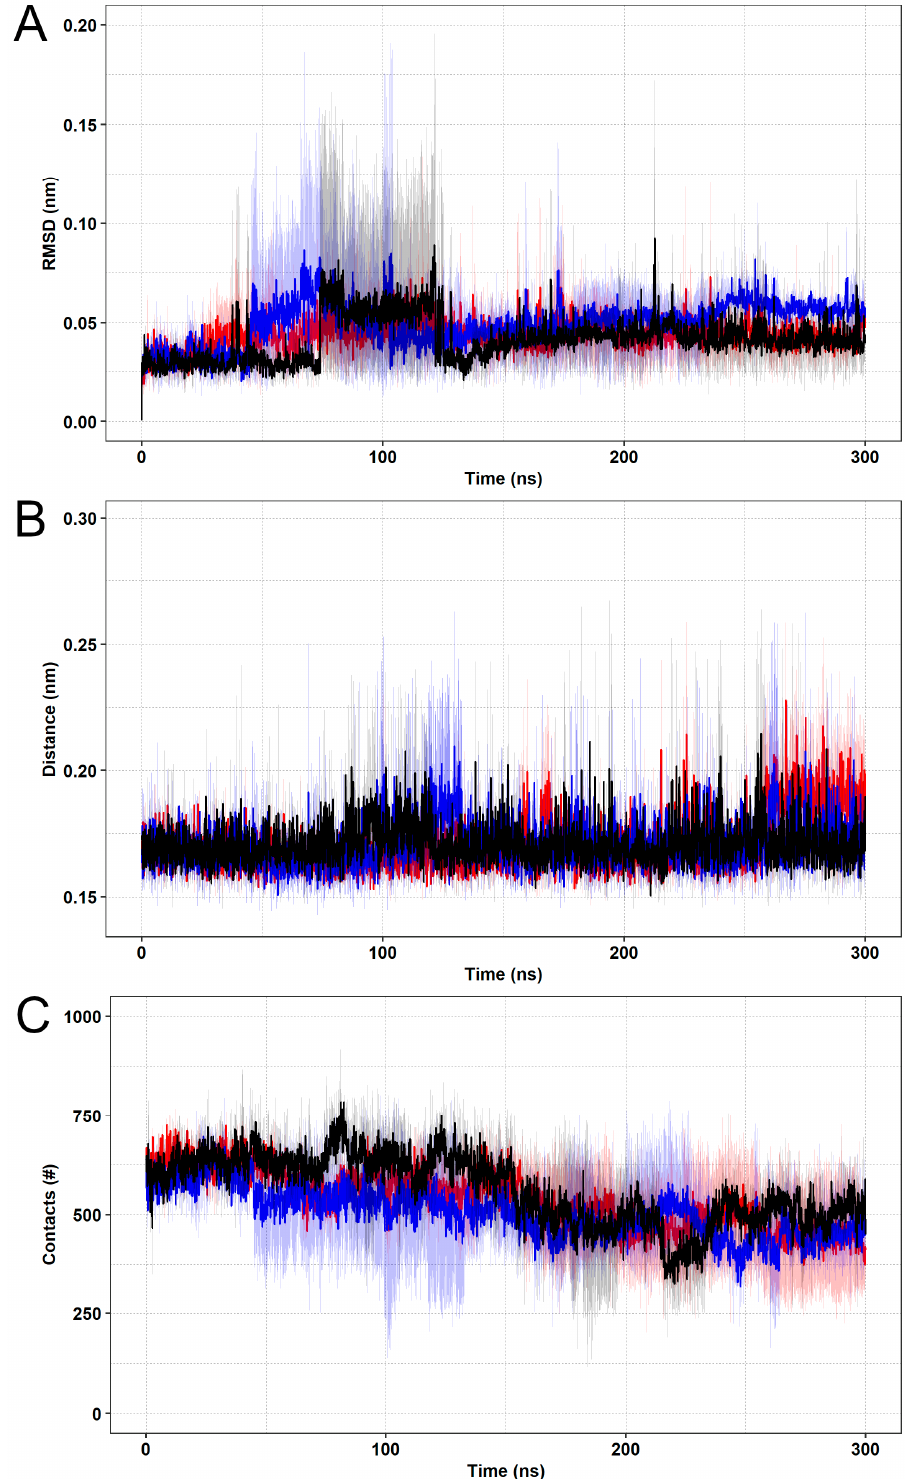
Figure 3. Ligand RMSD, minimum distances, and contact analyses. The wild-type is represented in black, variant A4V is represented in red, and variant D90A is represented in blue. The means (solid lines) and confidence intervals (smooth lines) are displayed for the triplicates. ( A ) The RMSD values computed from the SBL-1 atoms when complexed to SOD1 wild-type are shown as a function of time. ( B ) The minimum distances between SOD1 and SBL-1 are shown as a function of time. ( C ) The number of contacts formed between SOD1 and SBL-1 is shown as a function of time.